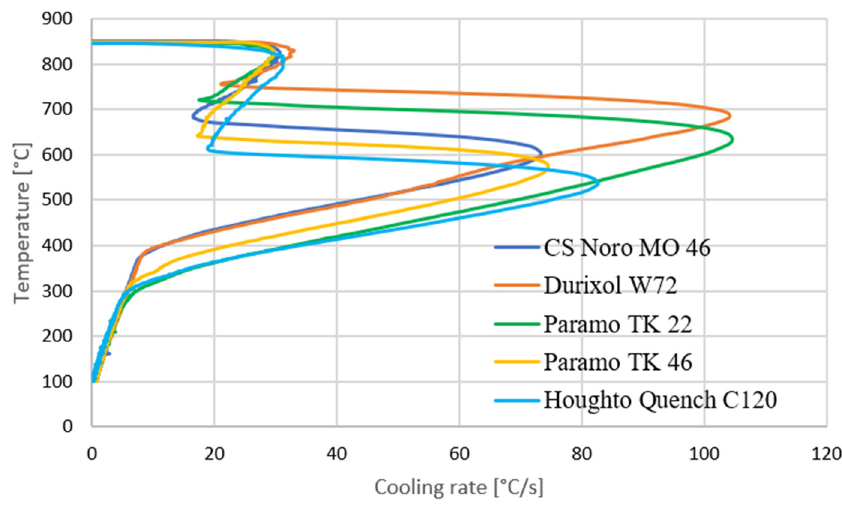
Figure 3. Cooling curves (temperature—cooling rate) according to ISO 9950.